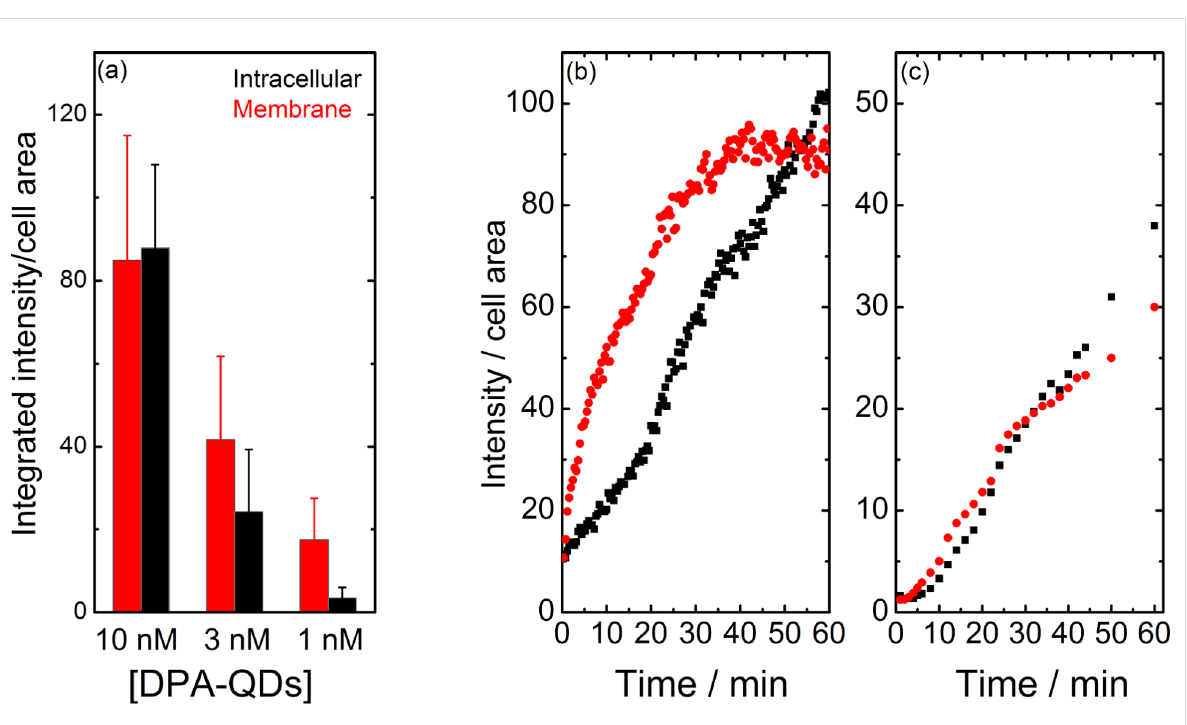
Figure 3: (a) DPA-QD uptake within 1 h by live HeLa cells as a function of NP concentration. (b) DPA-QD and (c) AuNC accumulation in the intracel- lular (black symbols) and membrane (red) regions of live HeLa cells within the first 60 min. Cells were exposed to (a, b) 10 nM DPA-QDs and (c) 1 µM DHLA-AuNCs. Images in panels a and b were reproduced with permission from [31]. Copyright 2010 American Chemical Society; the image in panel c was reproduced with permission from [34]. Copyright 2013 Royal Society of Chemistry.